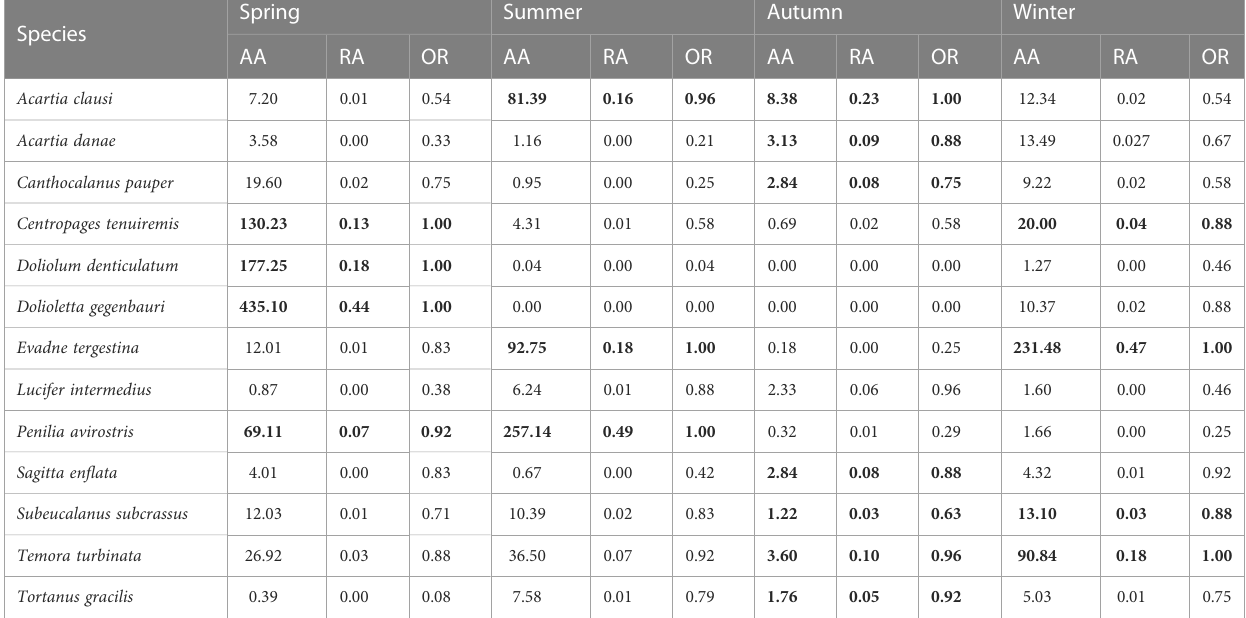
TABLE 2 The average abundance (AA), relative abundance (RA), and occurrence rate (OR) of dominant species in the research